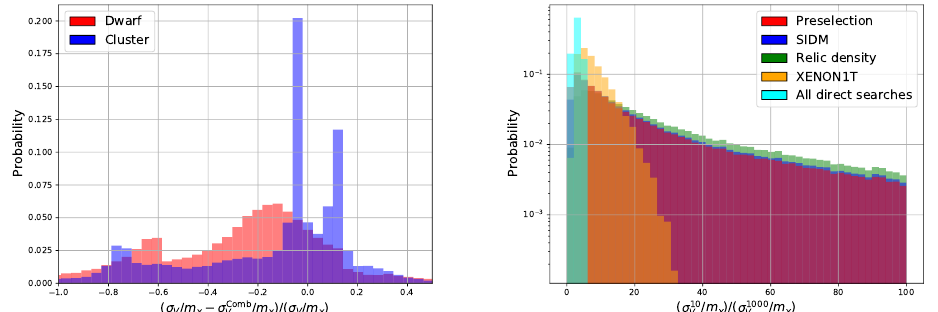
Figure 5 . Left panel: the relative difference between the analytical viscosity cross sections (divided by m ) as given in eq. (2.25) and numerically calculated ones (denoted by σ χ preselected NMSSM points are used. Right panel: the distributions of the ratio between the σ on dwarf and cluster scales for scanned points in the NMSSM with different selection